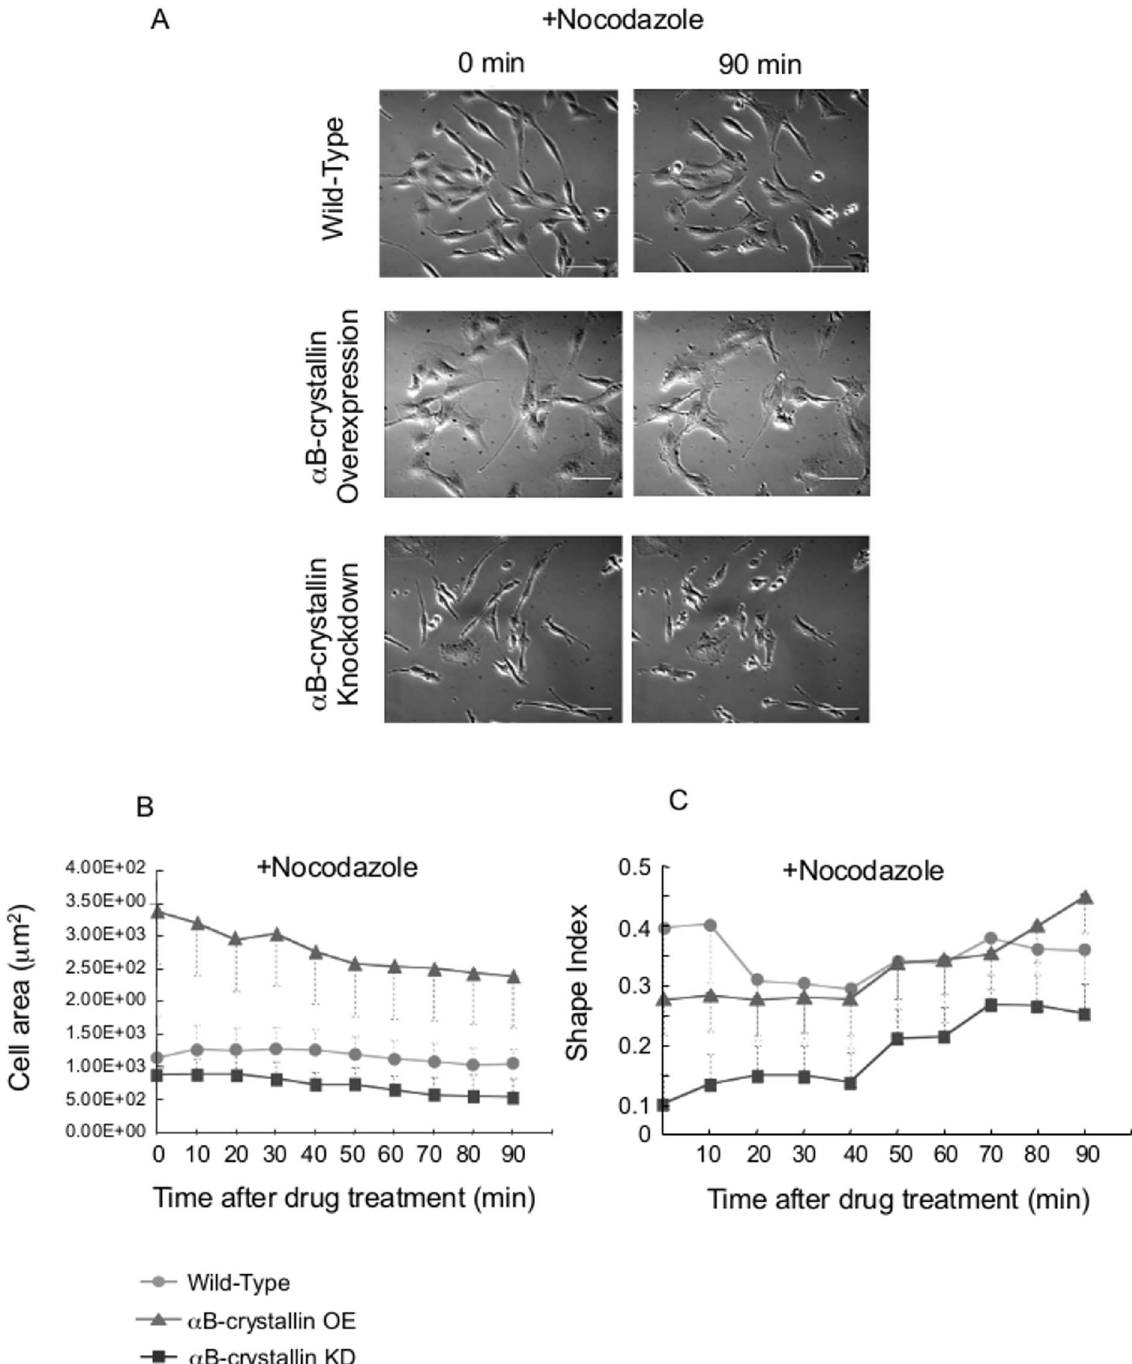
Fig 4. α B-crystallin-overexpressing cells and knockdown C6 cells: shape change after Nocodazole treatment. Images from just after the drug addition(final 10 μ g/mL; 0 min, left panel)and after 90 min (right panel)(A). Bar = 40 μ m. Cell area (B) and Shape index (C) changeof C6 cells after Nocodazoletreatment. N =